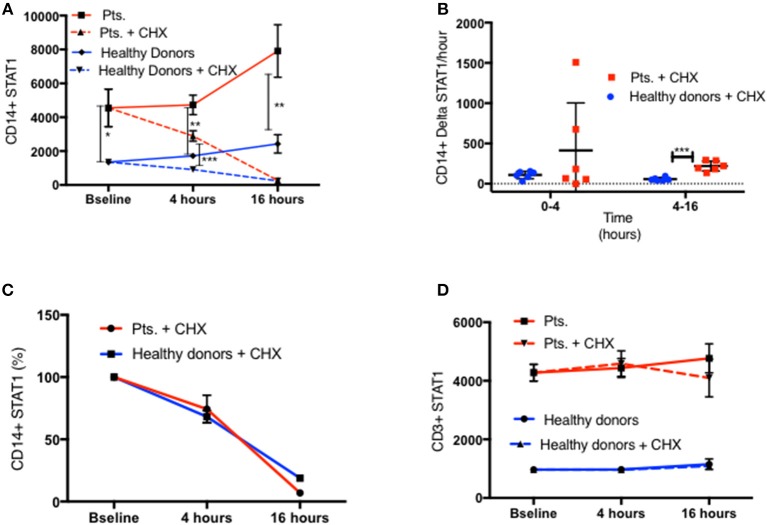
Similar STAT1 degradation rate in patients and healthy donors. (A) CD11b+/CD14+/CD64+ live monocytes STAT1 protein level in fresh PBMC of patients (red lines, n = 6) and healthy controls (blue lines, n = 8) at baseline and after 4 and 16 h with cycloheximide (CHX) 100 ng/ml (dotted lines) and without cycloheximide (solid lines), as measured by flow cytometry. Levels are expressed in geometric mean of fluorescence. (B) Average absolute decrease in STAT1 protein per hour in the monocytes of healthy donors (blue dots, n = 8) and patients (red squares, n = 6), during the first 4 h (0–4) and the last 12 h (4–16) of cycloheximide incubation. (C) Rate of decrease (%) in STAT1 protein level in healthy donor (blue line, n = 8) and patient (red line, n = 6) monocytes during the first 4 h (0–4) and the last 12 h (4–16) of cycloheximide incubation. (D) CD3+ lymphocyte STAT1 protein level in fresh PBMC of patients (red lines, n = 6) and healthy controls (blue lines, n = 8) at baseline and after 4 and 16 h with cycloheximide (CHX) 100 ng/ml (dotted lines) and without cycloheximide (solid lines) as measured by flow cytometry. Levels are expressed in geometric mean of fluorescence. *P < 0.05; **P < 0.01; ***P < 0.001, by t-test. Quantitative data represent mean ± SEM (D).